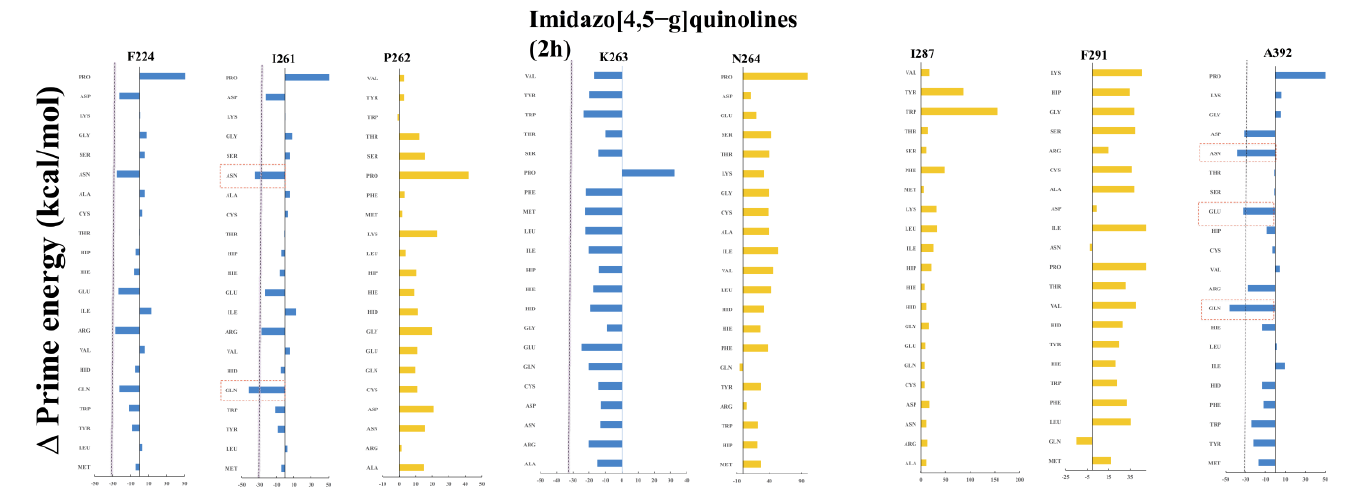
Figure 8. Energy quantification of mutational residues interacting with